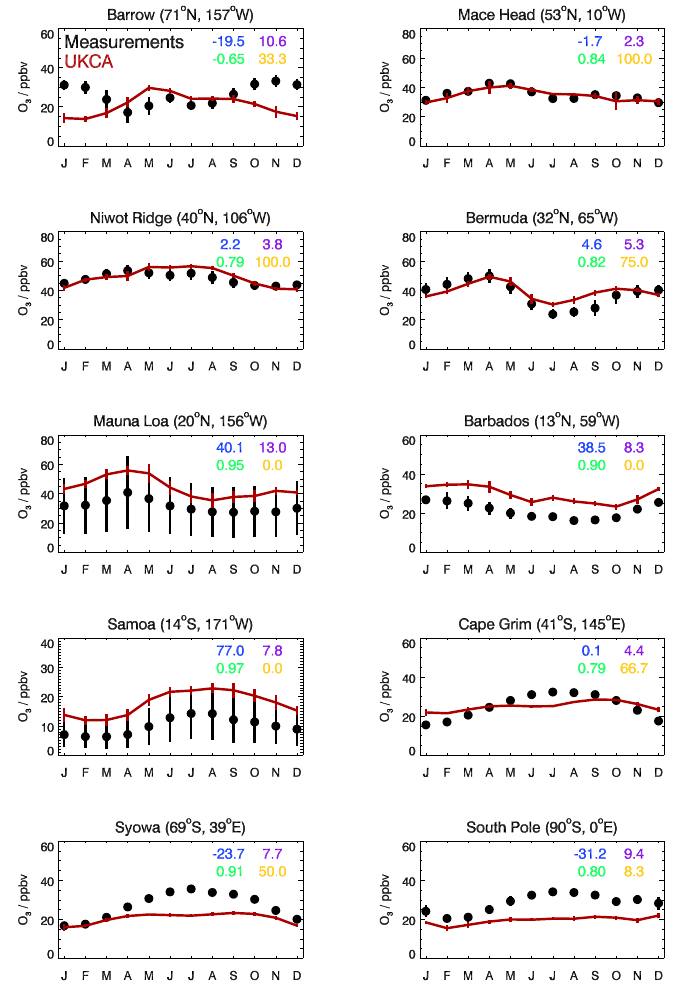
Fig. 25. Comparison between multi-annual monthly mean modelled surface O 3 concentrations with surface observations. The surface sites include Barrow (71 ◦ N, 157 ◦ W), Mace Head (53 ◦ N, 10 ◦ W), Niwot Ridge (40 ◦ N, 106 ◦ W), Bermuda (32 ◦ N, 65 ◦ W), Mauna Loa (20 ◦ N, 156 ◦ W), Barbados (13 ◦ N, 59 ◦ W), Samoa (14 ◦ S, 171 ◦ W), Cape Grim (41 ◦ S, 145 ◦ E), Syowa (69 ◦ S, 39 ◦ E), and the South Pole (90 ◦ S, 0 ◦ E). The relative annual mean bias (in %), the root mean square error (in ppbv), the correlation coefficient, and the model score (the percentage of months when the modelled and observed monthly mean concentrations are within 20% of each other; in %) are shown for each location in blue, purple, green, and orange, respectively. 97